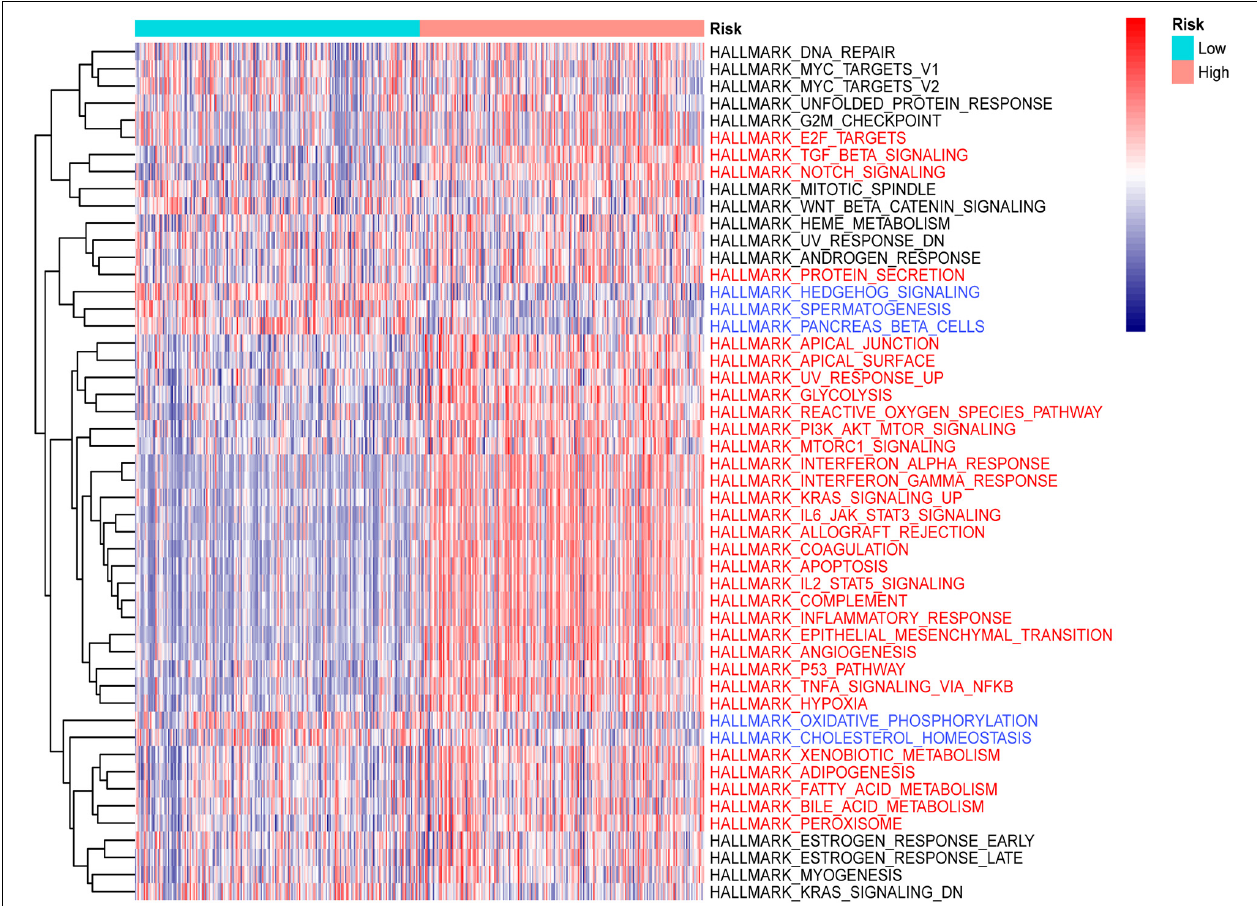
FIGURE 9 | Heatmap for the contribution of gene set variation analysis (GSVA) scores of hallmarks in low- and high-risk groups. Terms with red color are significantly up-regulated in the high-risk group, blue color represent down-regulation in low-risk group.